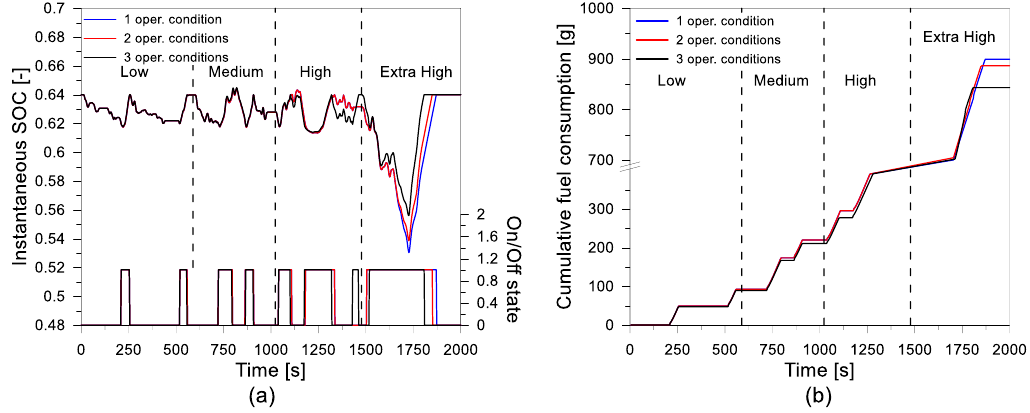
Figure 11. Instantaneous SOC ( a ) and cumulative fuel consumption ( b ) for the three-charging strategy during the WLTC driving cycle.